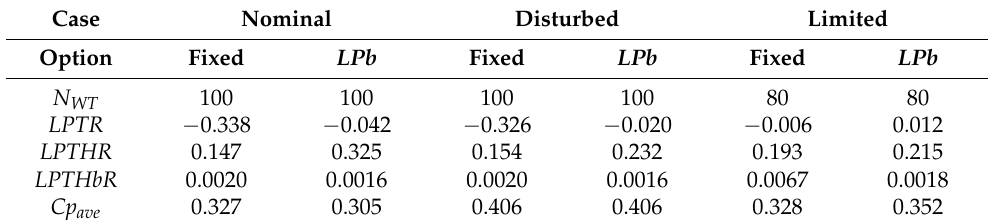
Table 3. Results of the instantaneous control for a one-year